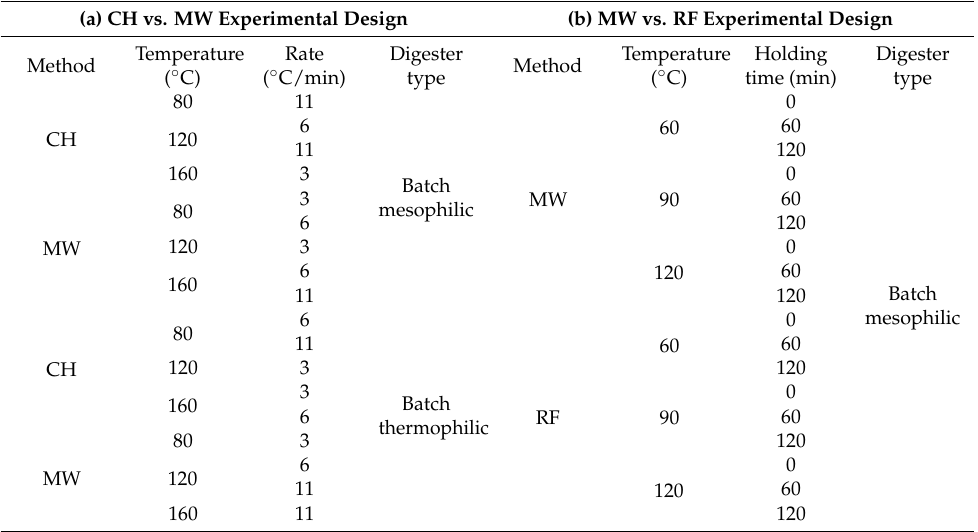
Table 3. The experimental design used for comparison of CH, MW, and RF pretreatment